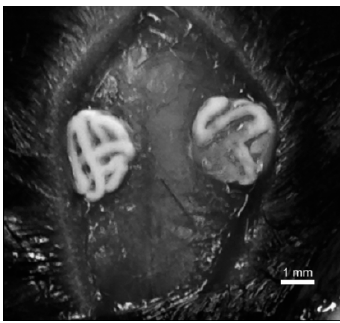
Figure 1. View on freshly implanted calcium phosphate cement (CPC) scaffolds in critical-size defects in mice calvaria before wound closure.